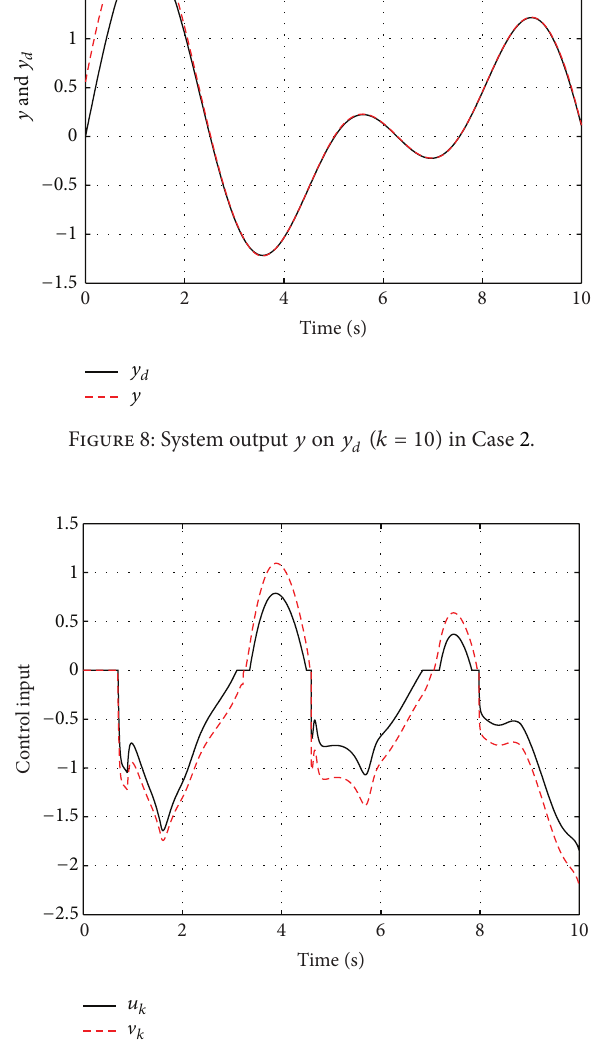
Figure 9: Control input 𝑢 𝑘 and V 𝑘 (𝑘 = 1) in Case 2.